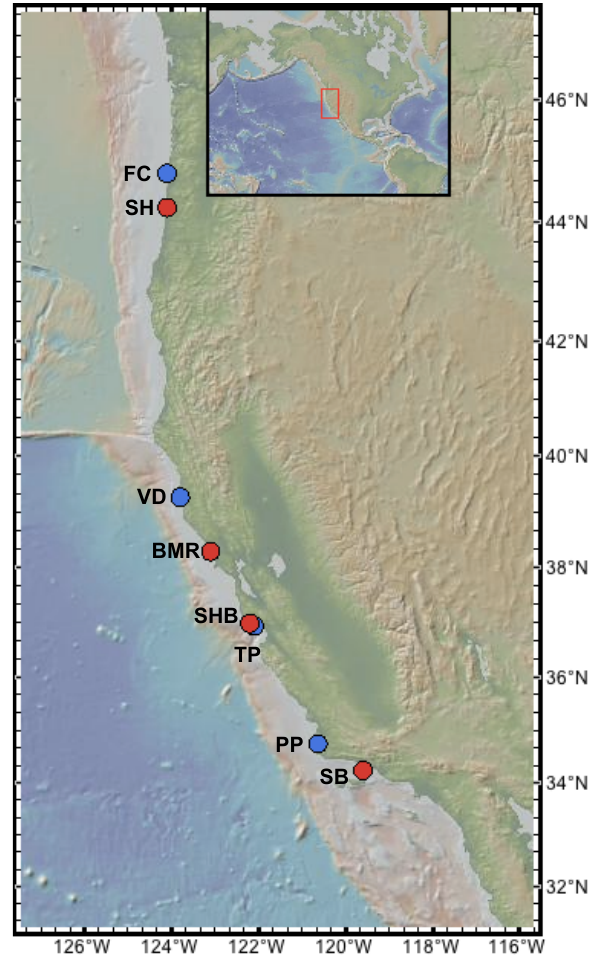
Fig. 1. Map of study area noting collection sites of adult urchins ( Strongylocentrotus purpuratus ) for spine samples (blue circles) and individuals spawned for culturing experiment (red circles). Site abbreviations as in Table